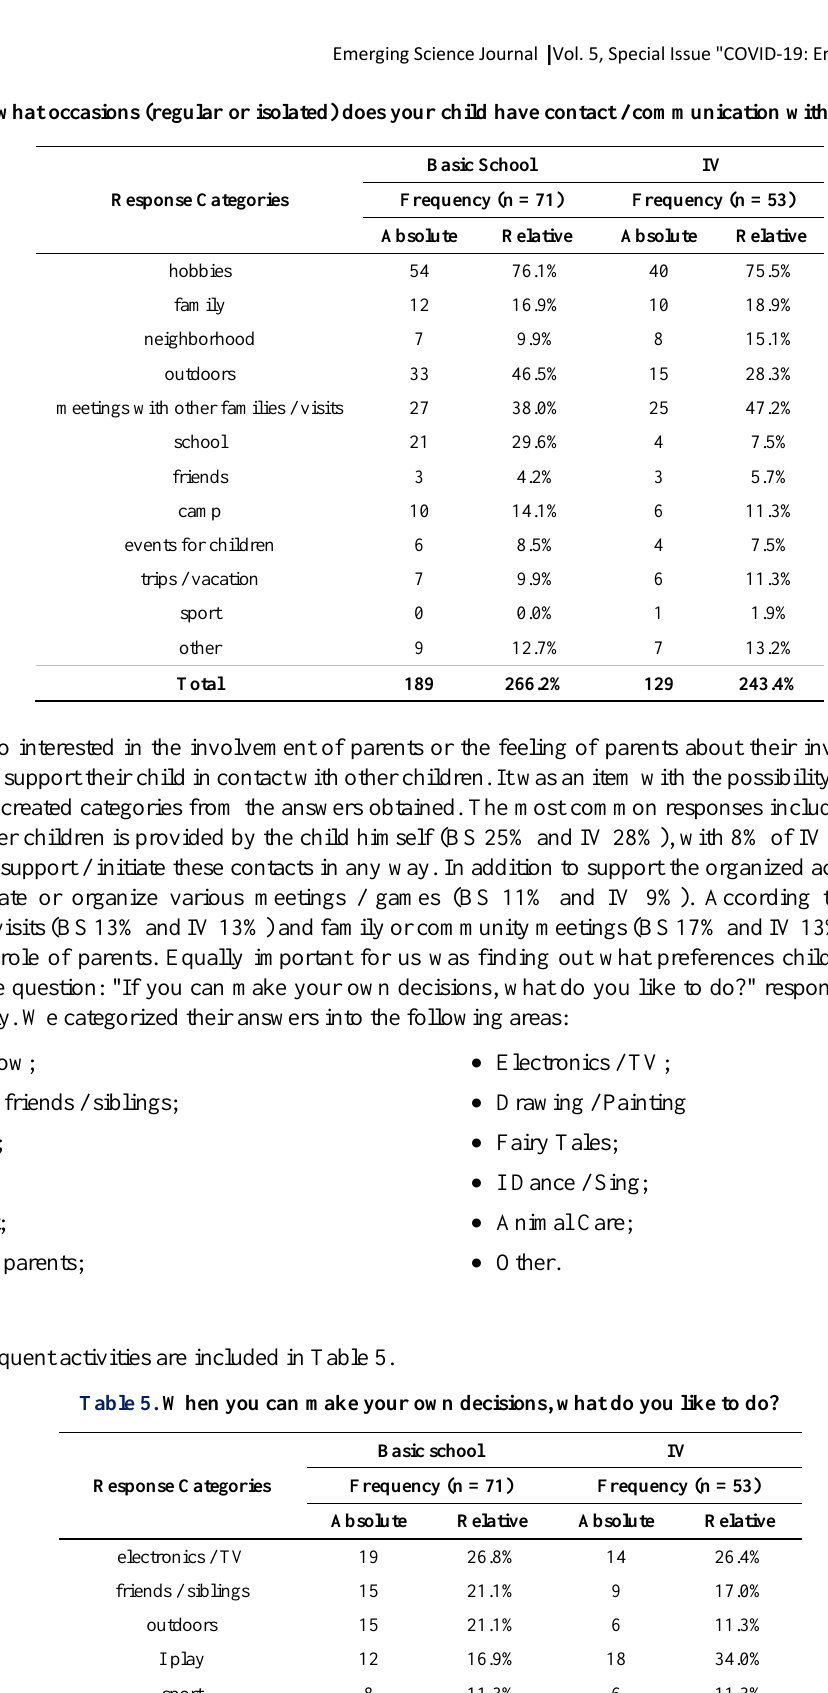
Table 4. On what occasions (regular or isolated) does your child have contact / communication with other children?